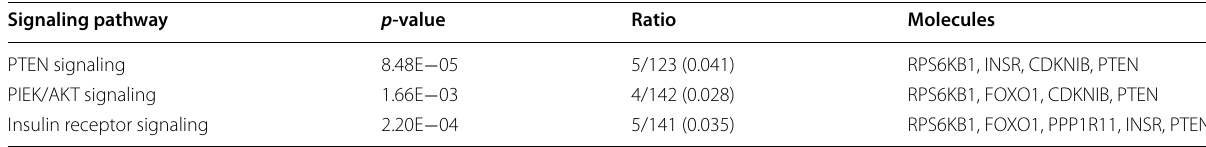
Table 2 Genes involved in the signaling pathways targeted by 11 over-expressed miRs in PDAC attained with Ingenuity Pathway Analysis (IPA) [12] Signaling pathway p ‑value